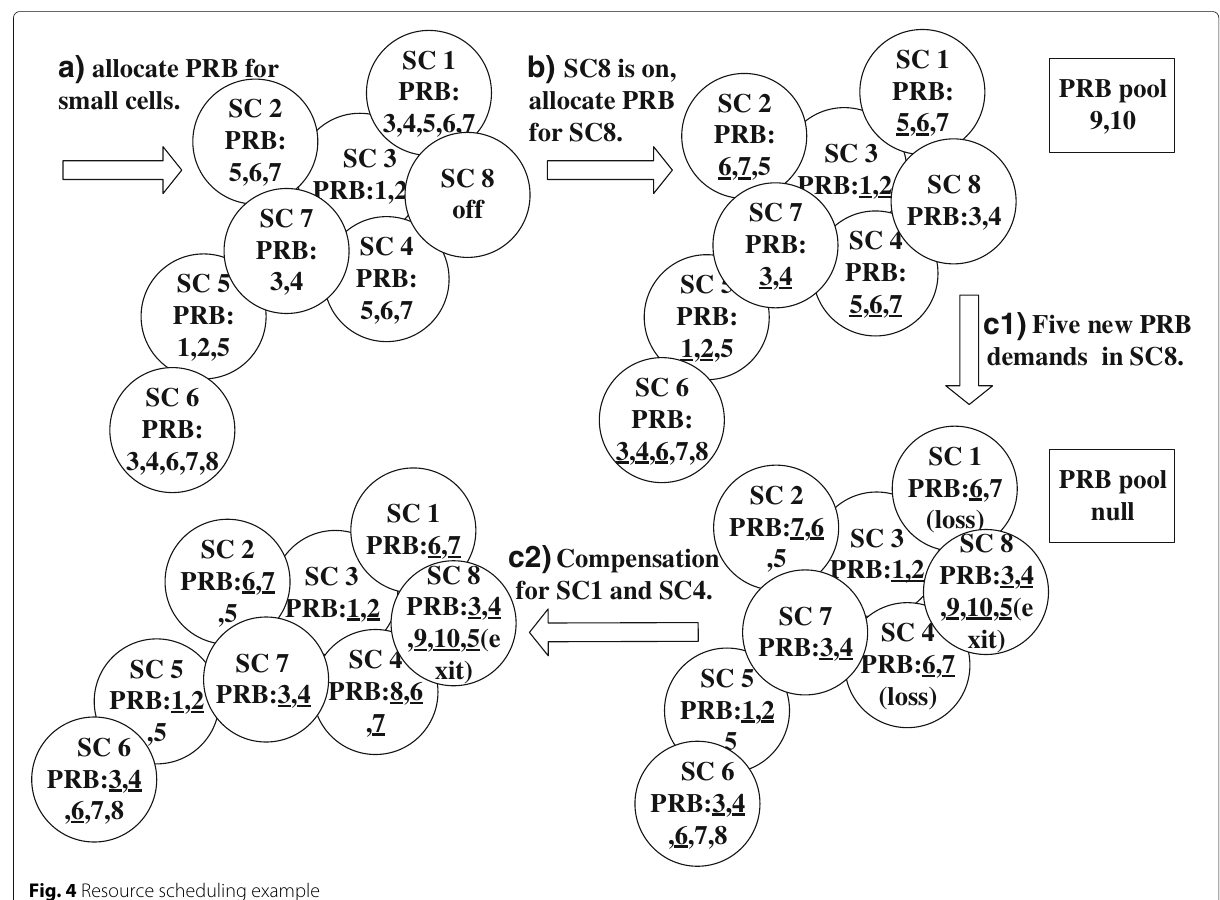
Fig. 4 Resource scheduling example